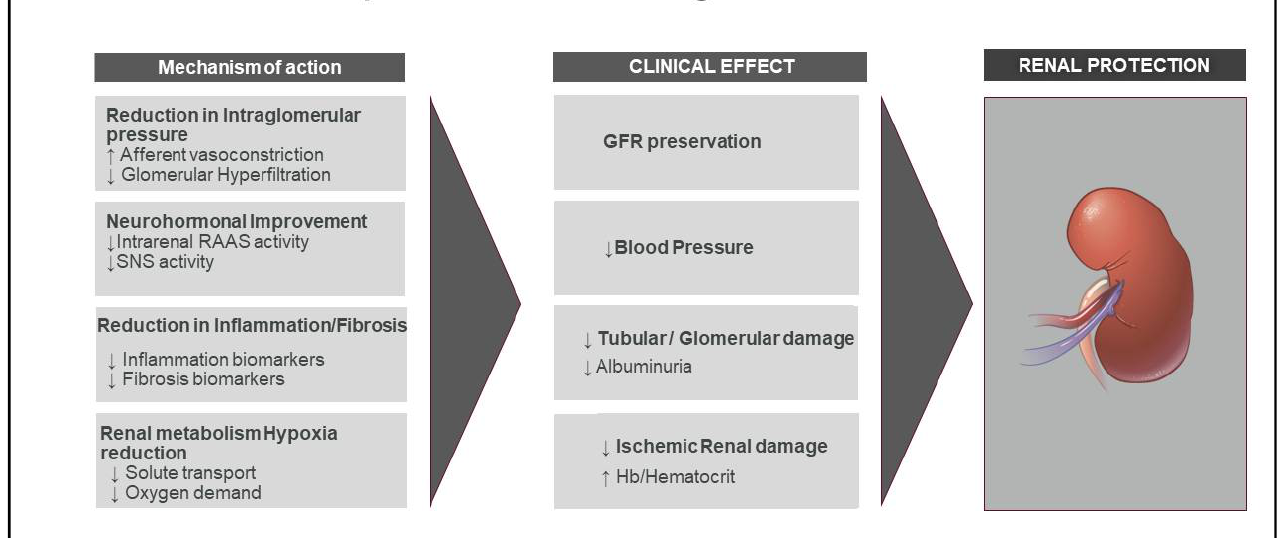
Figure 2. SGLT2is and renal protection: from biological mechanisms to clinical benefits. Renal protection by SGLT2 inhibitors is likely multifactorial. In the short term, SGLT2is promote diuresis and natriuresis as well as tubuloglomerular feedback activation, resulting in afferent arteriole vasoconstriction and a reduction in intraglomerular pressure, filtration fraction, and eGFR. Over a longer term, SGLT2is induce a reduction in inflammatory as well as interstitial fibrosis biomarkers together with an increase in hematocrit and mitigation of hypoxia in tubular cells. These changes result in a reduction in blood pressure and urine excretion and GFR preservation over